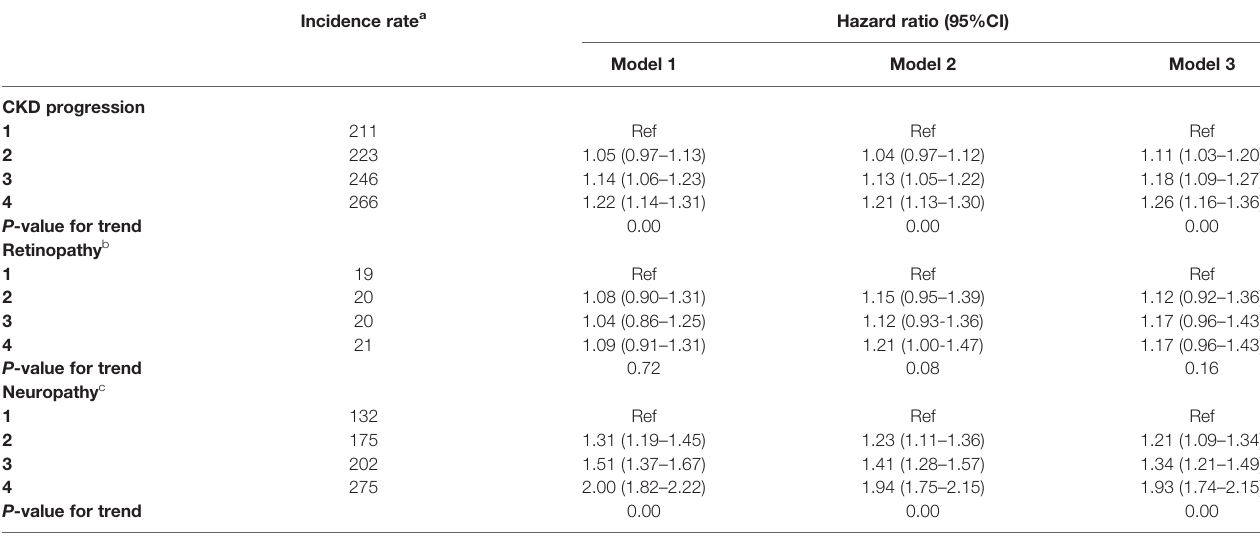
TABLE 3 | Hazard ratio (95% CI) of primary endpoints by fat mass index quartiles.